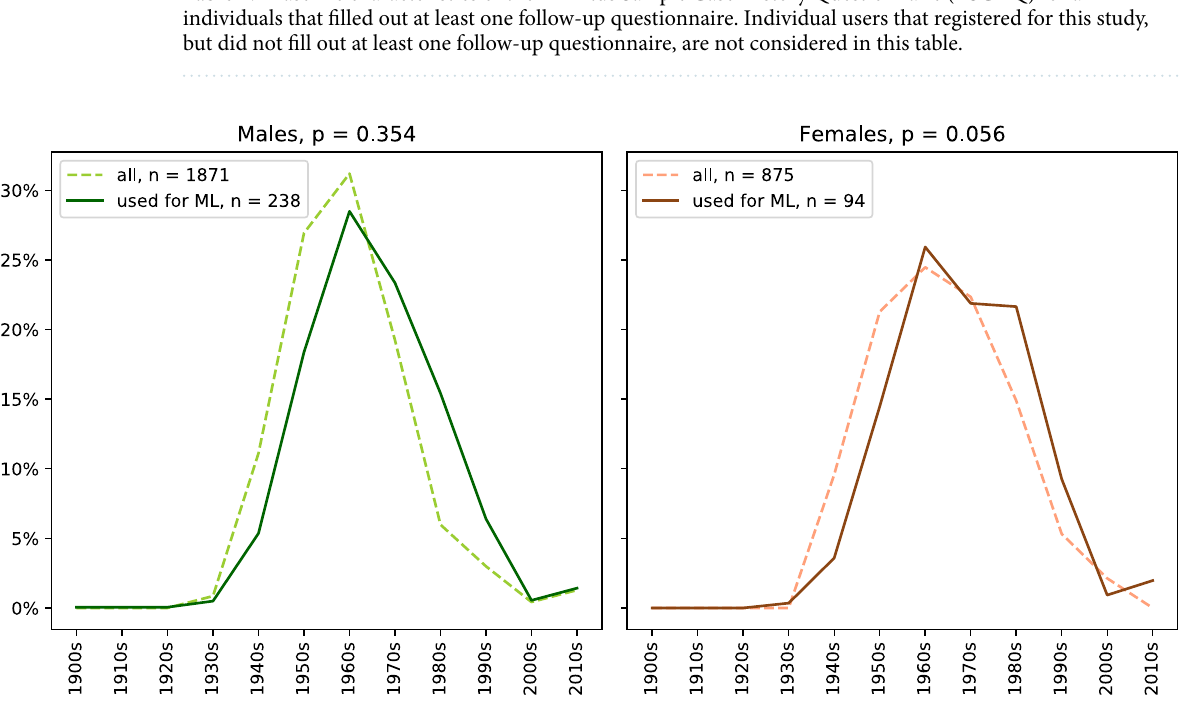
Figure 3. The dashed lines denote the age distribution for the all individuals, whereas the solid lines indicate the subset of individuals used for the machine learning calculations. This subset has a size of m = 11,877, and contains 238 + 94 individual users. For all users, m equals to 80,969. Note that the high p-values for both groups indicate equality of the age